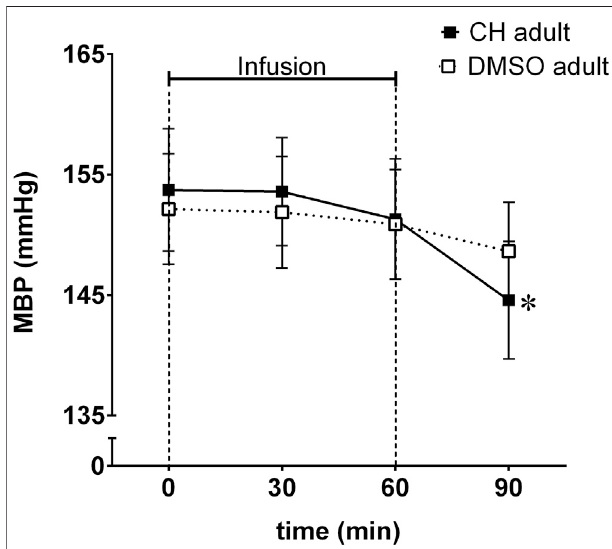
FIGURE 2 | Mean blood pressure (MBP) reordered in acute experiment in anesthetized spontaneously hypertensive rats (SHR) receiving an hour long infusion of chymostatin (CH, 2 mg/kg, n (cid:1) 7) or it ’ s solvent (0.05% DMSO, n (cid:1) 8); * p ≤ 0.05 vs. baseline value within the same group (multivariate analysis of variance ANOVA with repeated measurements, followed by Duncan ’ s post-hoc test).